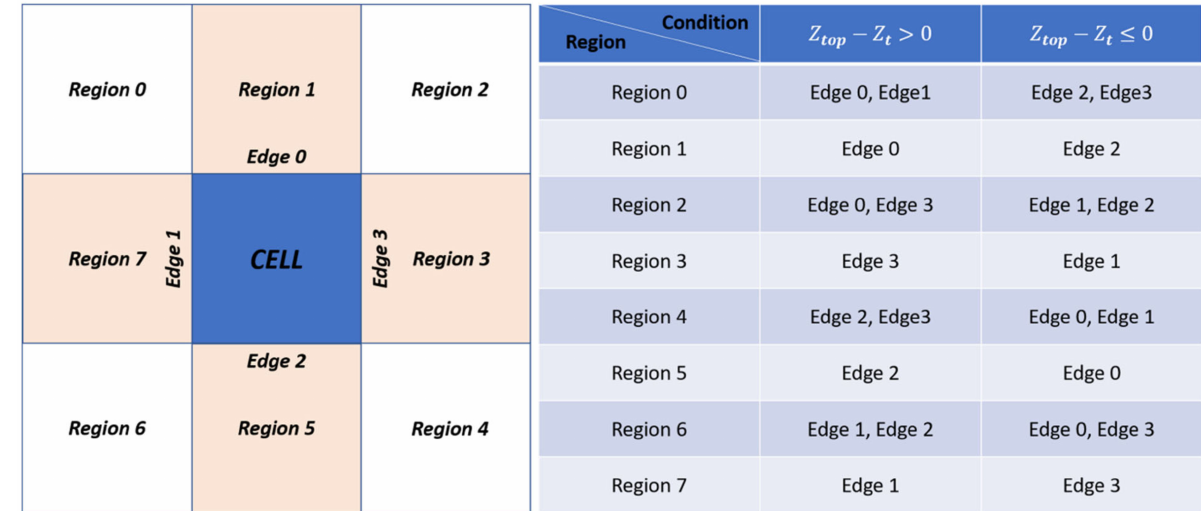
Figure 6. Diagram of edge selection policy. The picture on the left shows the top view of a cell. The possible areas of all test points are divided into 8 regions. A test point may be located at one of 8 different regions. Z top represents the elevation of the top plane of a cell; Z t represents elevation of the test point. Our viewpoints are sampled on the top plane of a cell; their elevations are the same. According to 2 different conditions, as is shown in the table, samples will be taken on different edges.